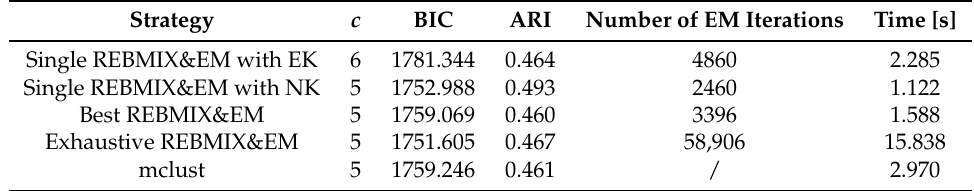
Table 4. Results on the dataset with high level of overlap between clusters.